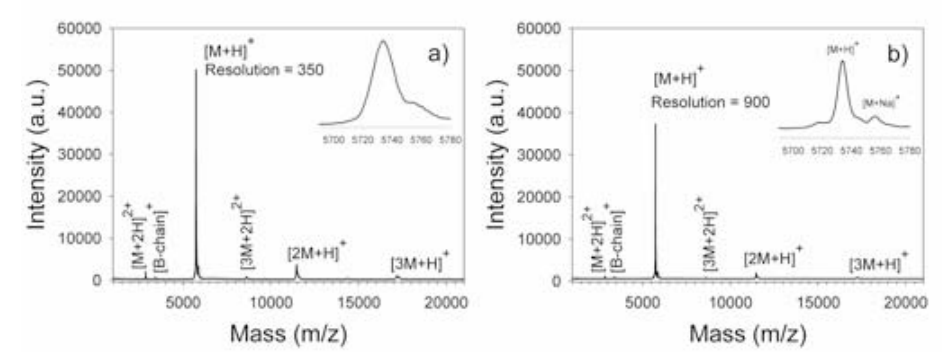
Fig. 2 MALDI mass spectra (summation of 1000 insulin particles premixed with the matrix PMC) obtained with a) continu- ous extraction and b) delayed extraction. The insets show the main protonated peak.